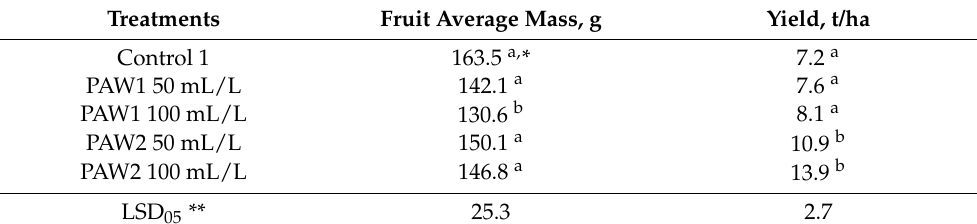
Table 1. Impact of PAW on fruit average mass and yield.